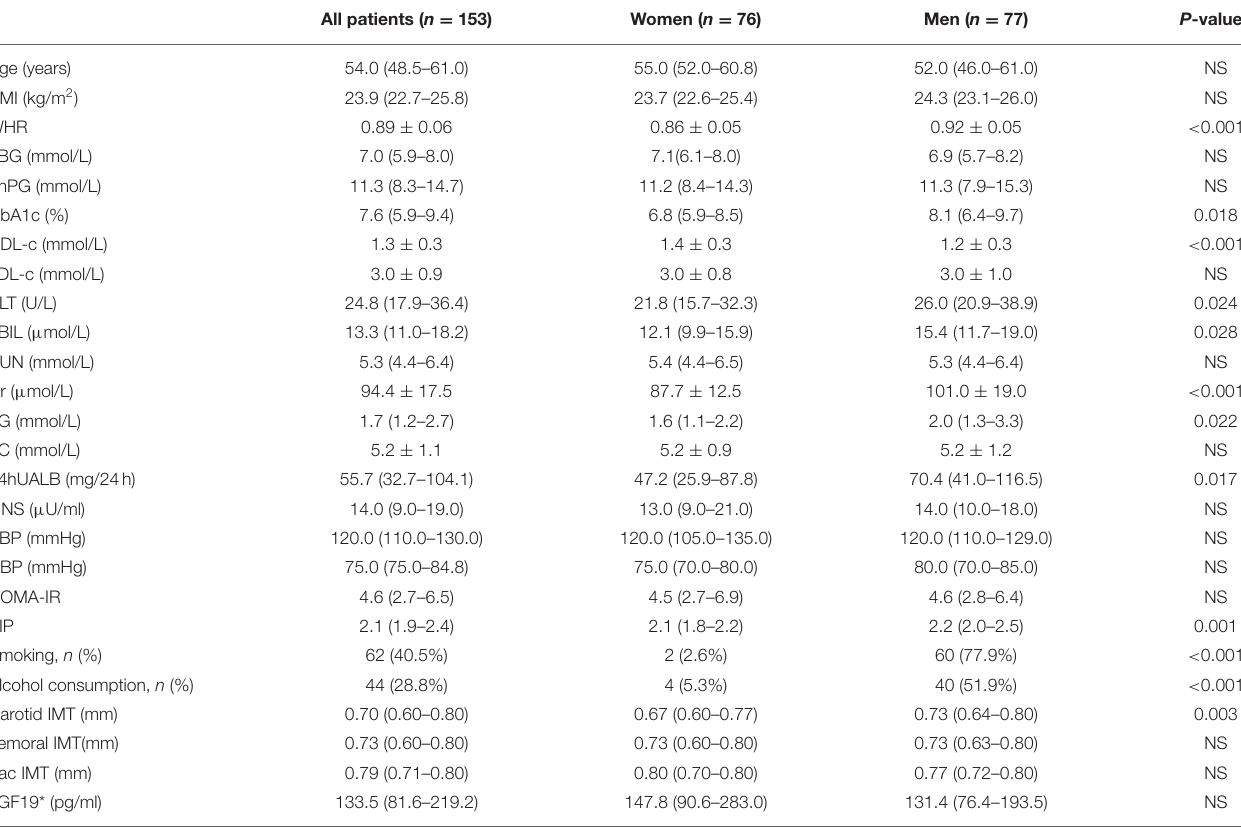
TABLE 1 | Anthropometric parameters and clinical characteristics among subjects. All patients ( n =